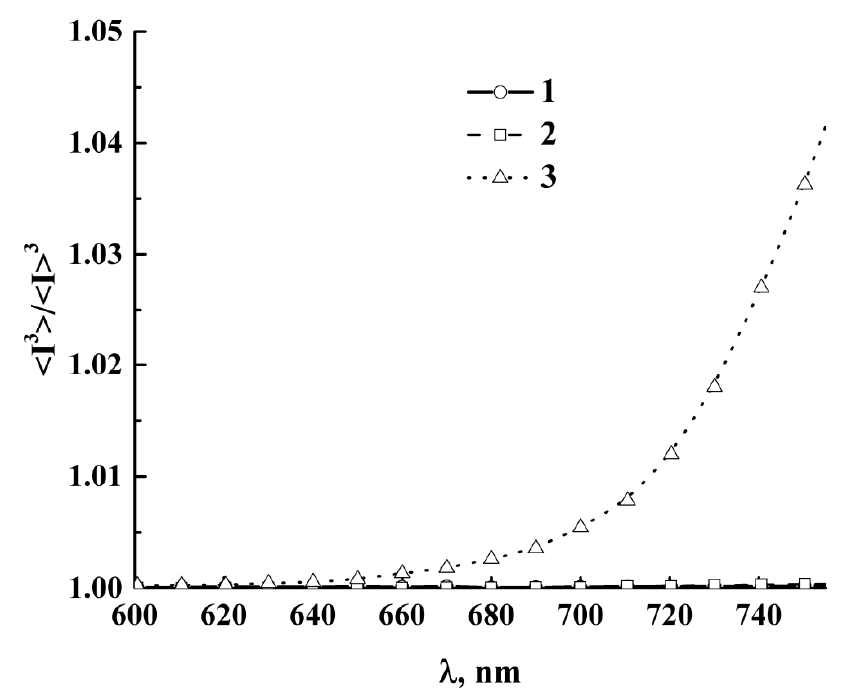
Figure 8. Wavelength-dependent values of the normalized third-order moment of intensity fluctuations in the examined spectral region for the TiO 2 -based system in the “static” (2) and scan (3) modes. The values of for the dye solution (1) are given for reference.